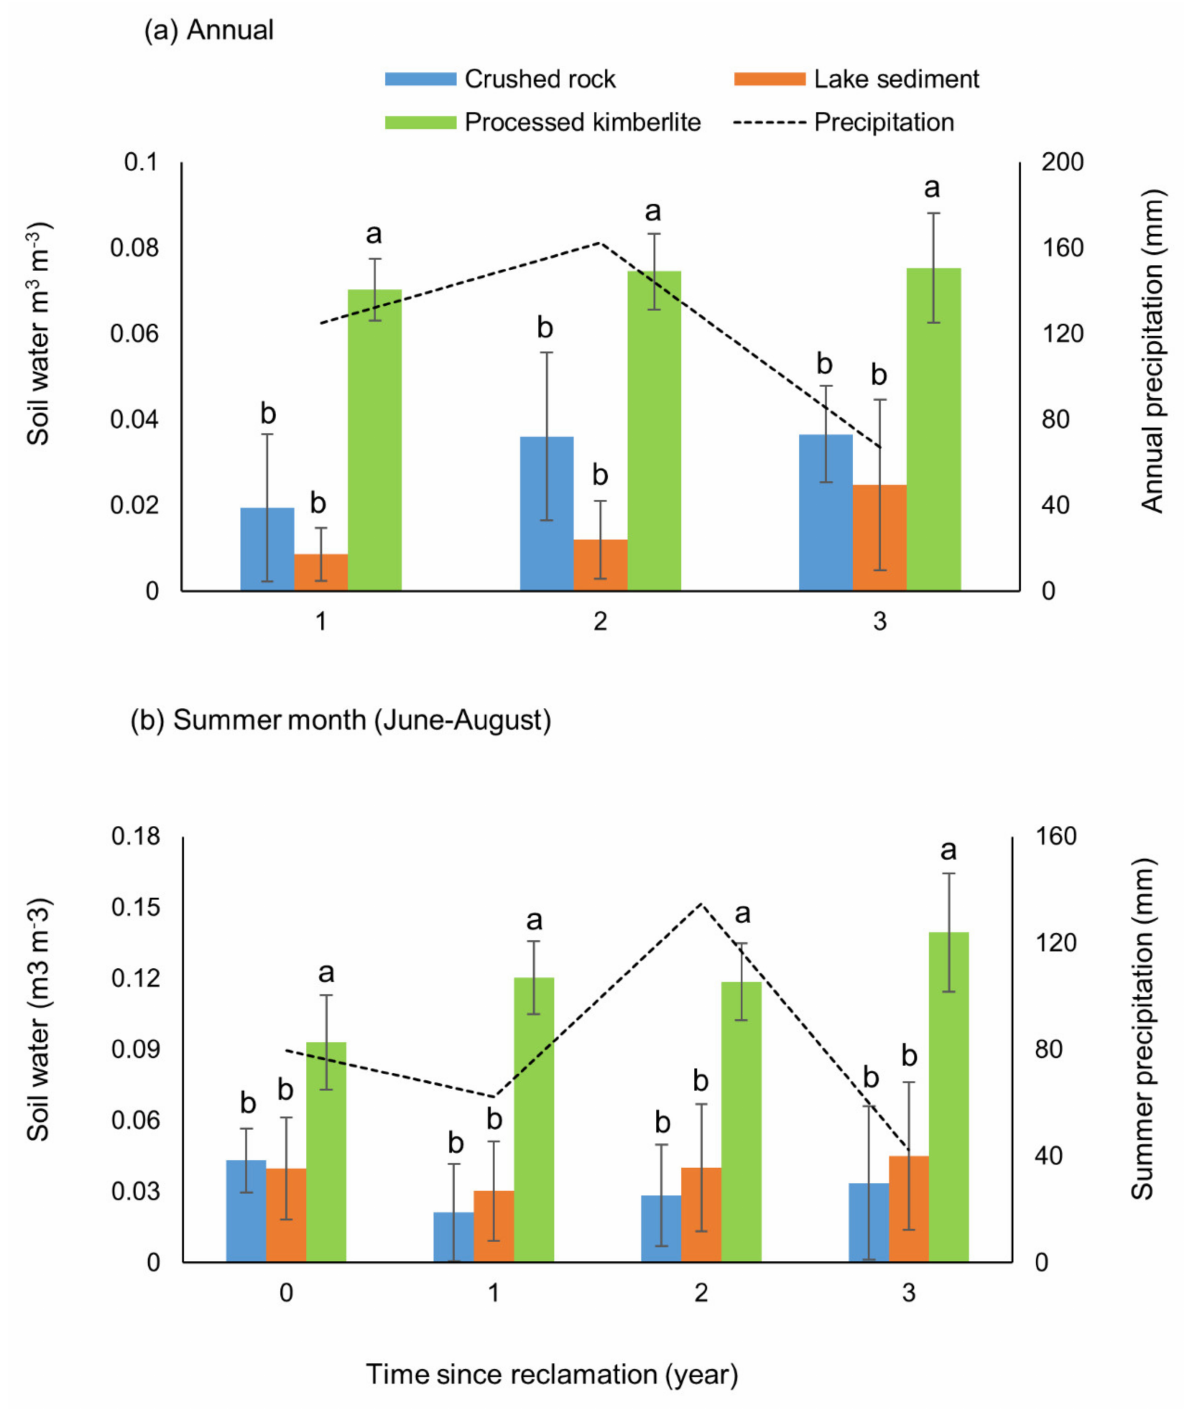
Figure 4. Mean ( a ) annual and ( b ) summer month water content by substrate type and precipitation at the research sites. Different letters indicate significant differences at p = 0.05 in Tukey HSD post hoc